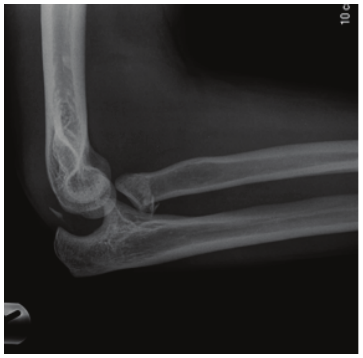
Figure 1: Fracture dislocation of the elbow with avulsed fragment of olecranon within the joint.